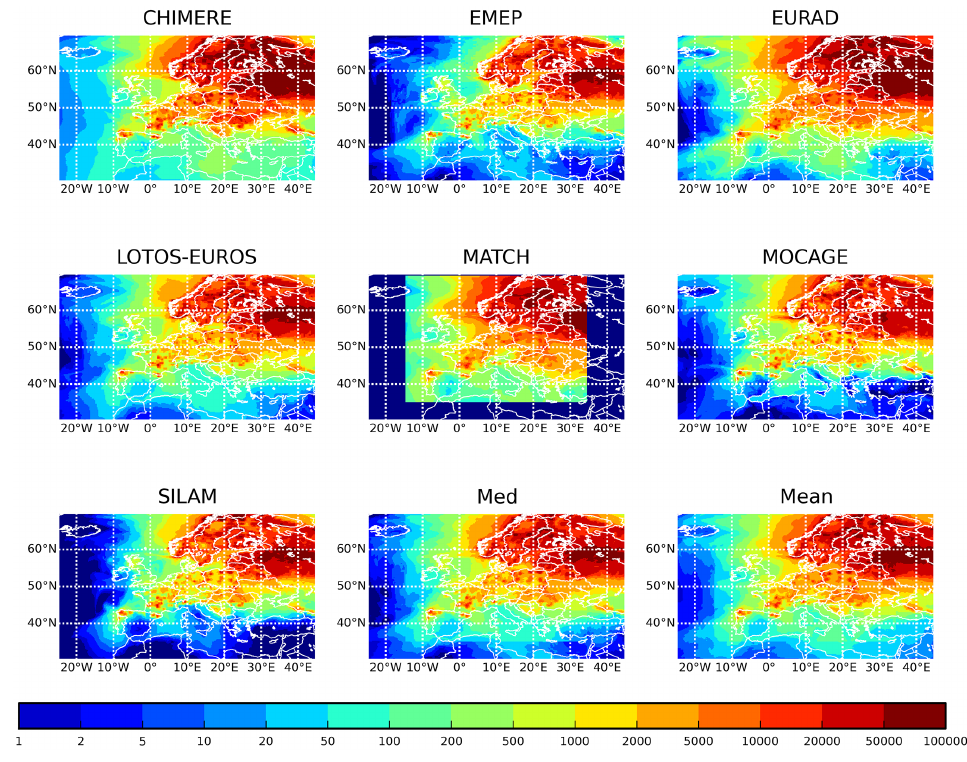
Figure 1. Seasonal pollen index (SPI, sum of daily concentrations) 2013 (pollendaym − 3 ).